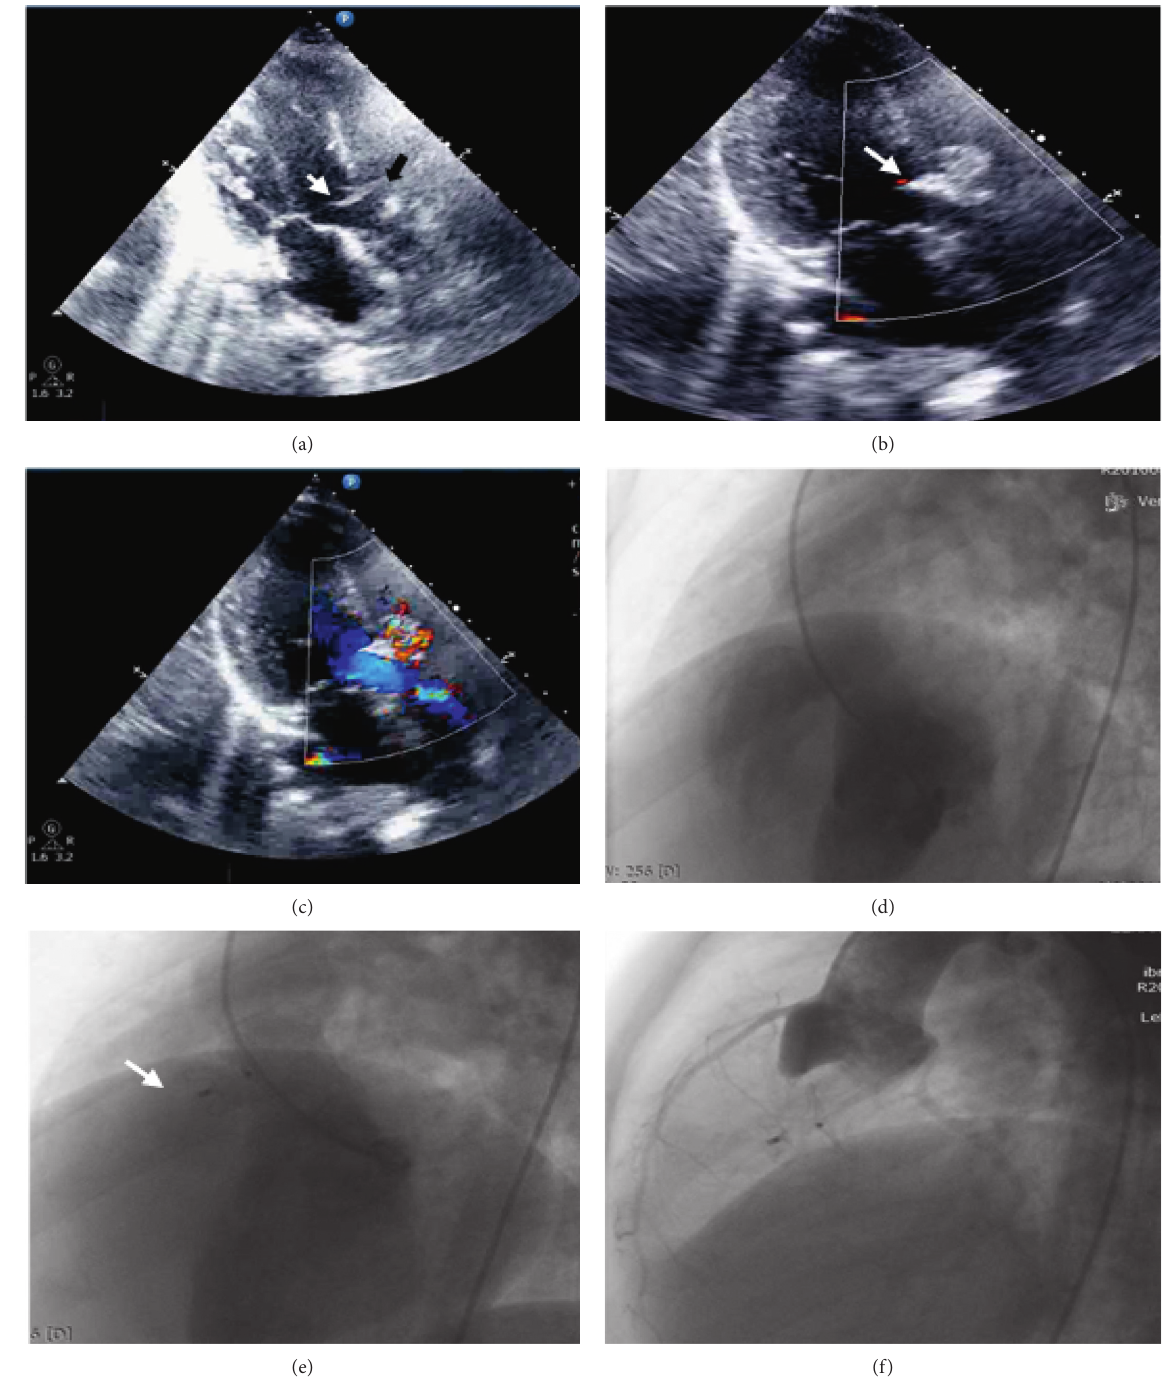
Figure 4: (a) Parasternal long axis 2D echocardiographic image of a 13-year-old female patient demonstrates moderate-to-large subaortic perimembranous VSD with 15% aortic override (black arrow) distal to a significant subaortic ridge (white arrow). (b) Cross-sectional parasternal long axis 2D echocardiographic image shows ADO-I (16–14mm) closing the defect and compressing the subaortic ridge toward the IVS. (c) Modified parasternal long axis 2D echocardiographic image with color flow mapping documenting that ADO-I compresses the subaortic ridge successfully with complete closure of the VSD with no AR. (d) Left ventriculogram in the left anterior oblique (70 ° ) and cranial (20 ° ) projection demonstrating a moderate-to-large sized subaortic VSD with 15–20% aortic override and peak systolic pressure gradient across the LVOT of 20 mmHg. (e) Left ventriculogram in the left anterior oblique (70 ° ) and cranial (20 ° ) projection documents excellent device position (arrow) with a small residual shunt through it (which completely disappeared at follow-up). (f) Aortogram in the lateral (90 o ) and cranial [20] projection demonstrating no AR despite mild prolapse of the RCC. The peak systolic pressure gradient across the LVOT decreased to 10